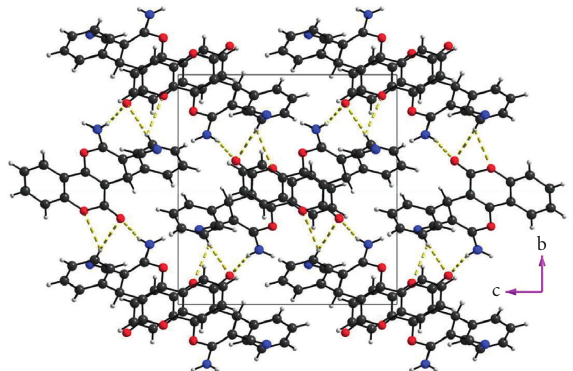
Figure 3: Projection view of the crystalline structure of Chrom-D along the “ a ”-axis showing the intermolecular hydrogen bonds with dashed